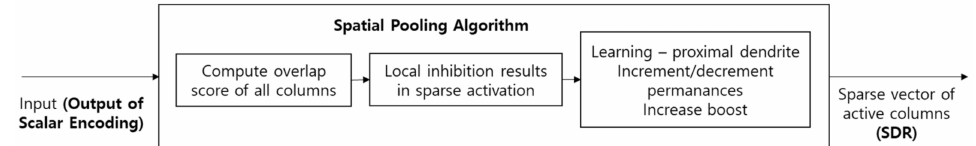
Figure 11. Processes for spatial